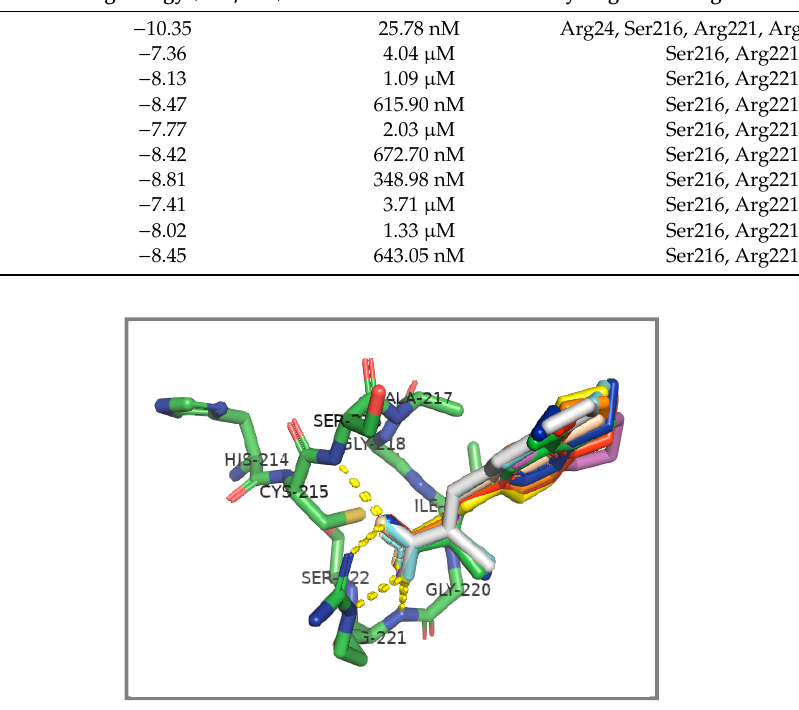
Table 3. Binding energies calculated for the compounds by using Autodock 4.2.